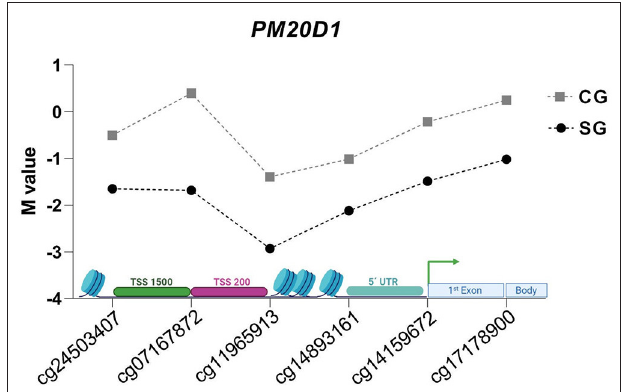
FIGURE 4 | M values of evaluated CpG sites in DMR of PM20D1 gene in SG e